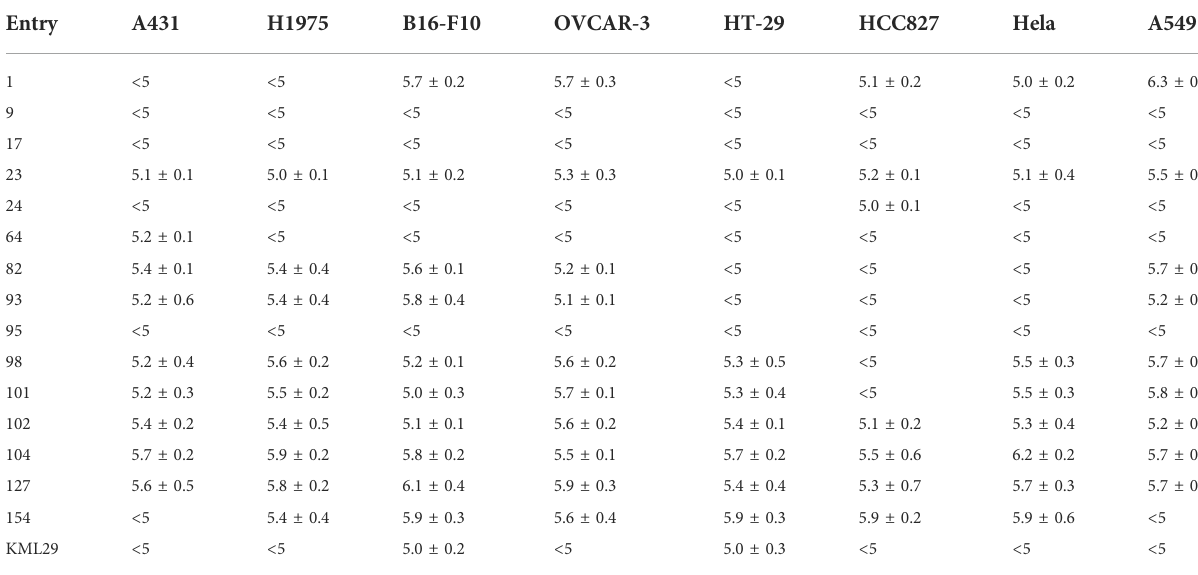
TABLE 2 Antiproliferation activity of the compounds in a panel of cancer